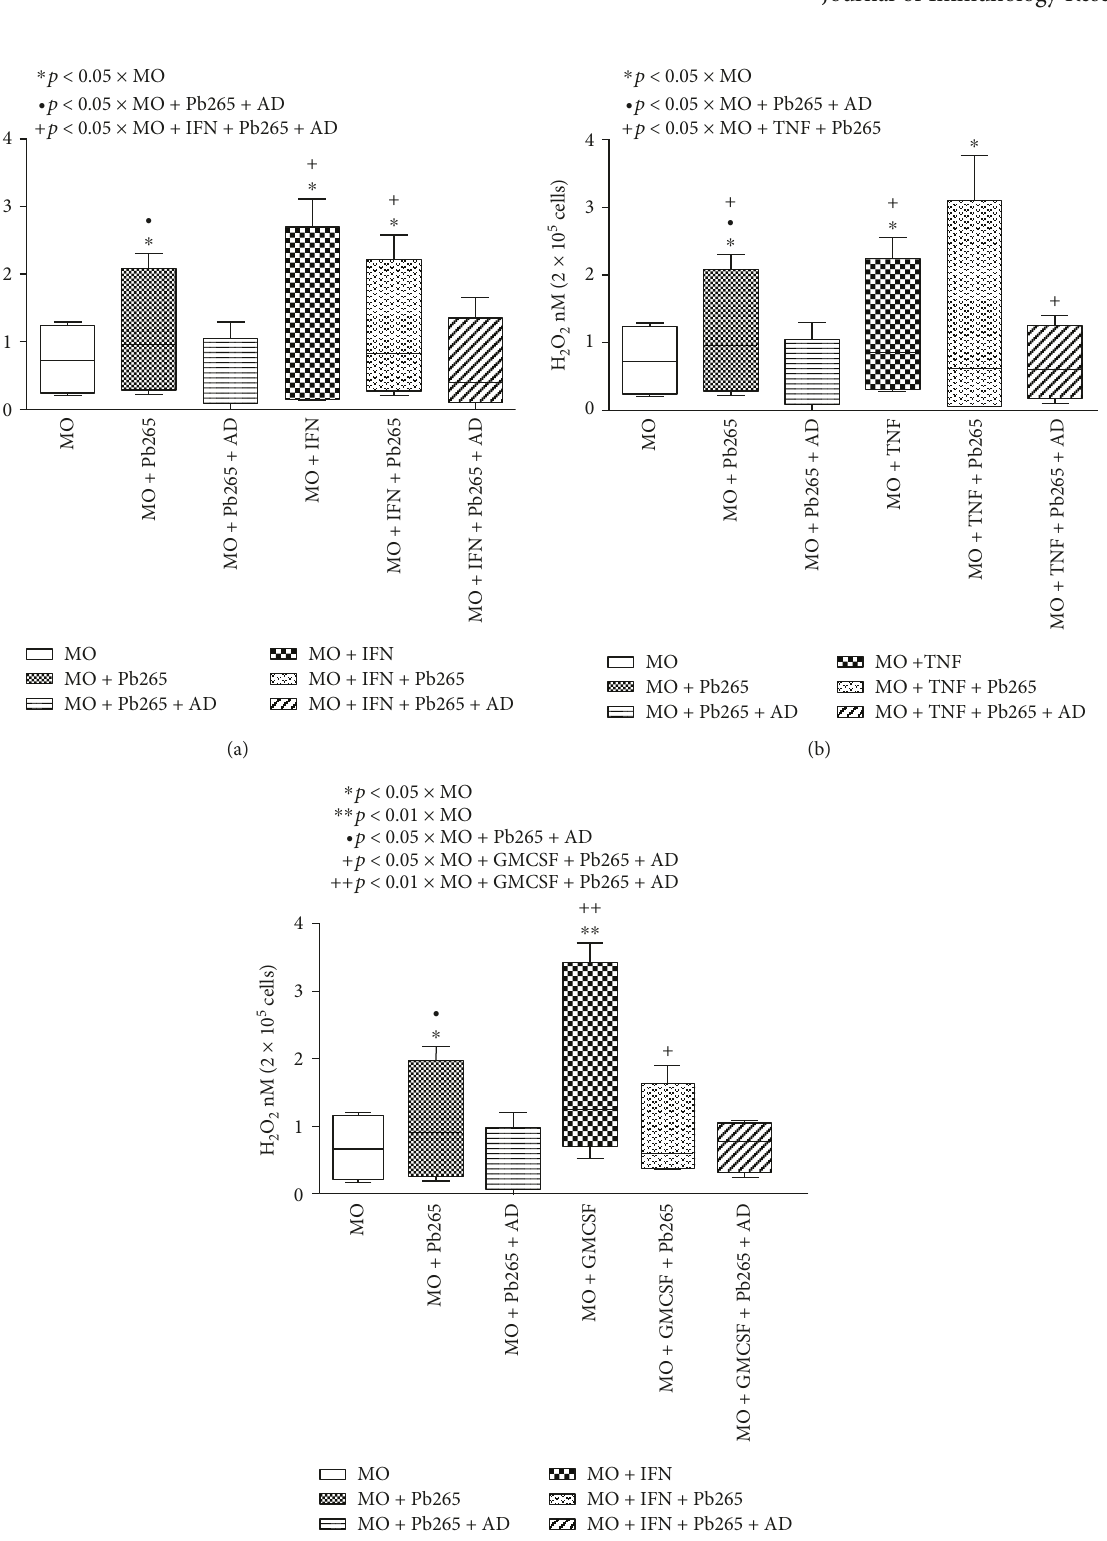
Figure 5: Hydrogen peroxide (H O ) production by monocytes (MO) treated or not with IFN- γ (a), TNF- α (b), and GM-CSF (c) for 18 hours 2 2 in the presence or absence of the anti-Dectin-1 monoclonal antibody (AD) and challenged or not with Pb265 for 4 hours. Box-and-whisker plot showing data distribution of 8 healthy volunteer donors. Statistical signi fi cance between groups is